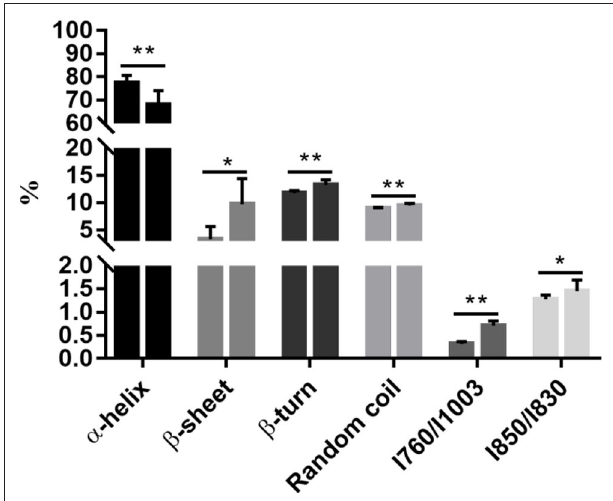
FIGURE 1 | Postmortem aging caused a reduction of the α -helix content but an increase in the β -sheet, β -turn, and random coil contents, accompanying with the exposure of tryptophan. All data were presented as means and standard deviations. Asterisks denote that the contents of α -helix, β -sheet, β -turn, random coil, and the ratios of I − 1 760cm /I − 1 1003cm and I − 1 850cm /I − 1 830cm differ significantly between the two time points. * P < 0.05; ** P <